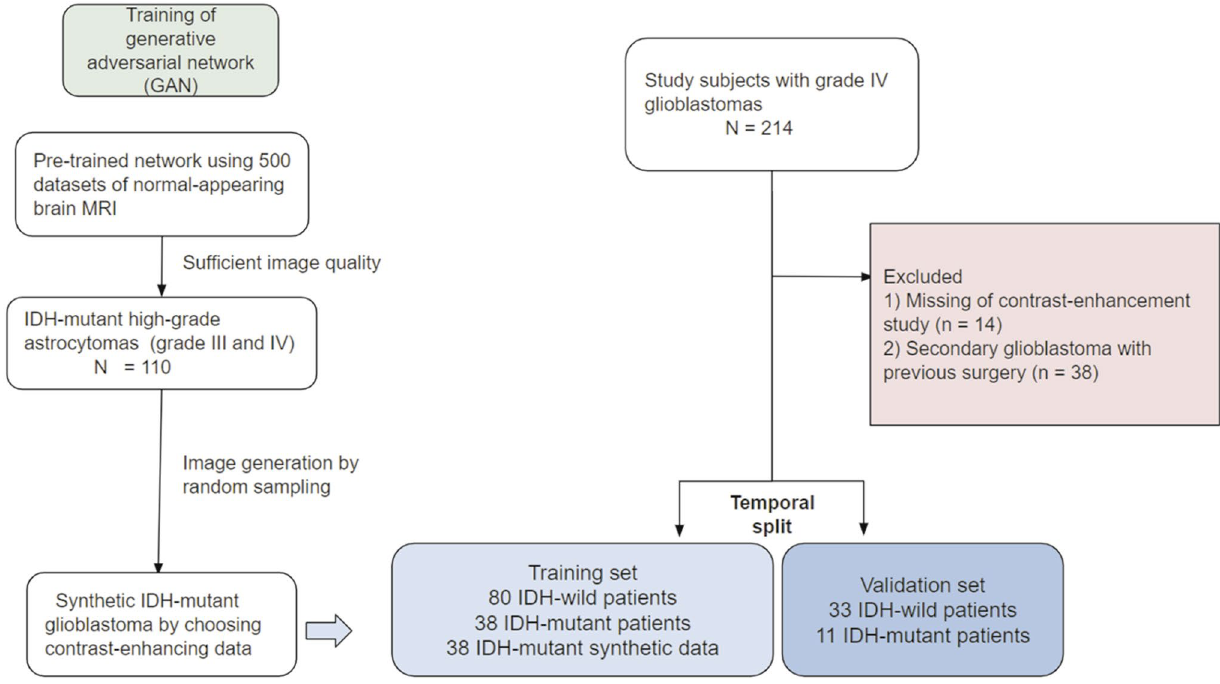
Figure 1. Process for inclusion of the study population and the training dataset for the generative adversarial